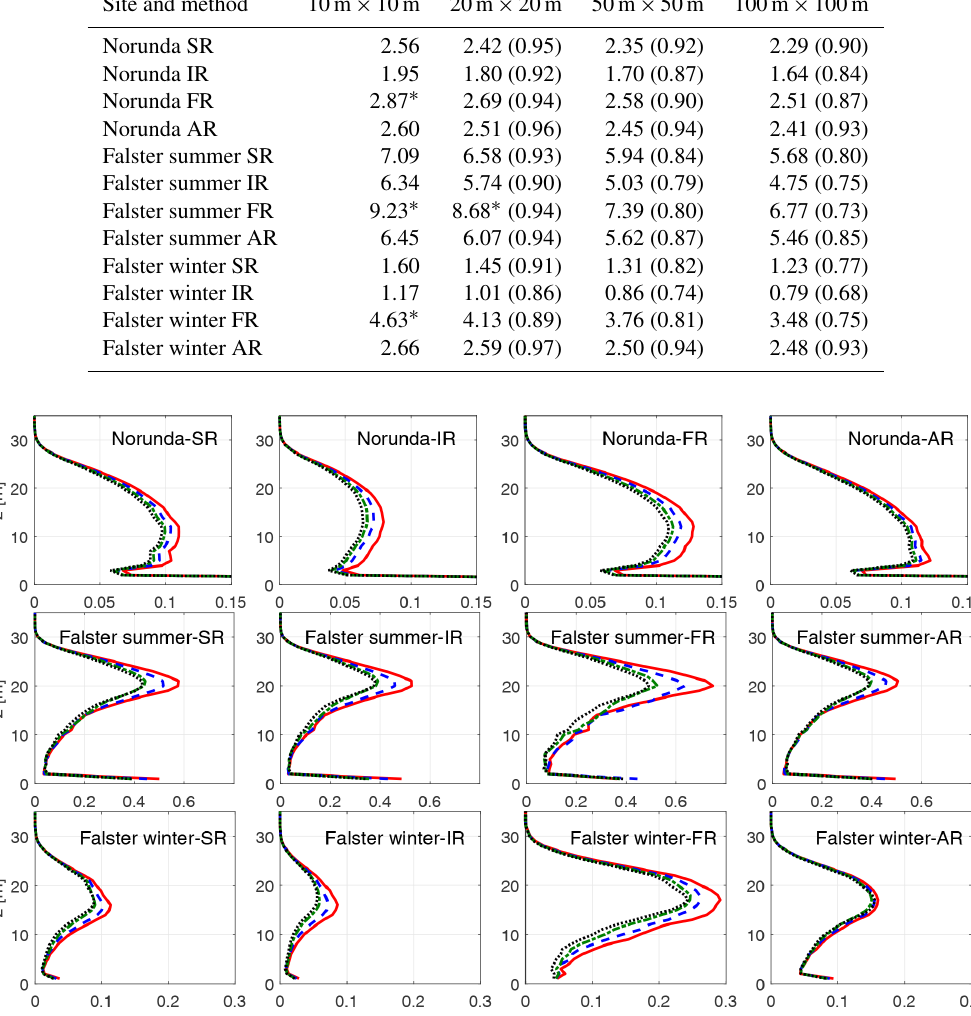
Figure 7. Average PAD profiles for the Norunda (top row), Falster summer (middle row) and Falster winter (bottom row) sites. The averages are based on a 10m × 10m (red full line), 20m × 20m (blue dashed line), 50m × 50m (green dash dotted line), and 100m × 100m (black dotted line) resolution using the SR, IR, FR, and AR methods (left to right),